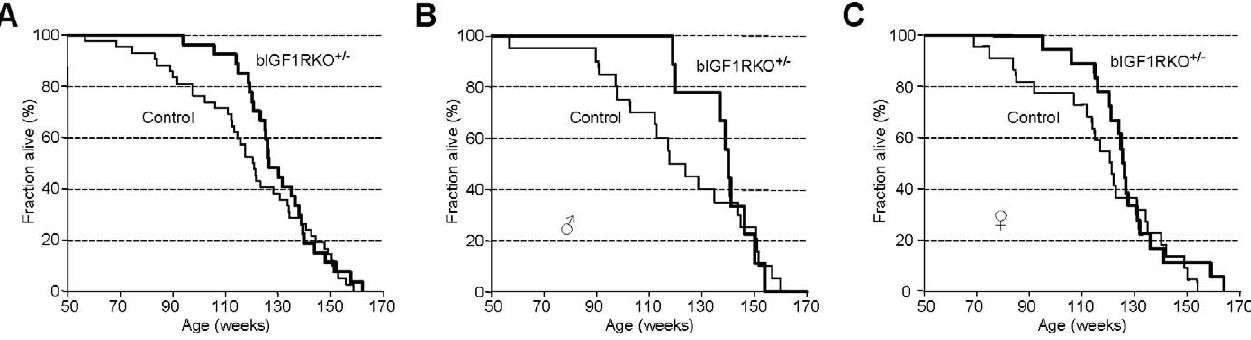
Figure 6. Lifespan Analysis (A) Survival curves show that bIGF1RKO þ / (cid:2) mice, on average, outlived their control littermates, although the maximum lifespan was similar for mutants and controls. (B and C) Separate survival curves for males and females. Mean lifespan for bIGF1RKO þ / (cid:2) males was 966 6 28 d versus 853 6 43 d for male controls; Mean lifespan for bIGF1RKO þ / (cid:2) females was 888 6 27 d versus 821 6 36 d for female controls. Differences were significant in Cox’s test for males, females, and for both sexes combined when curves were censored before week 140, 130, and 135, respectively.